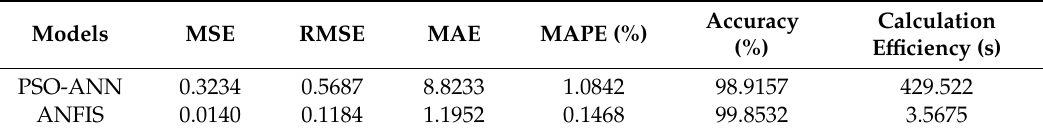
Table 2. Performance and forecast accuracy of the